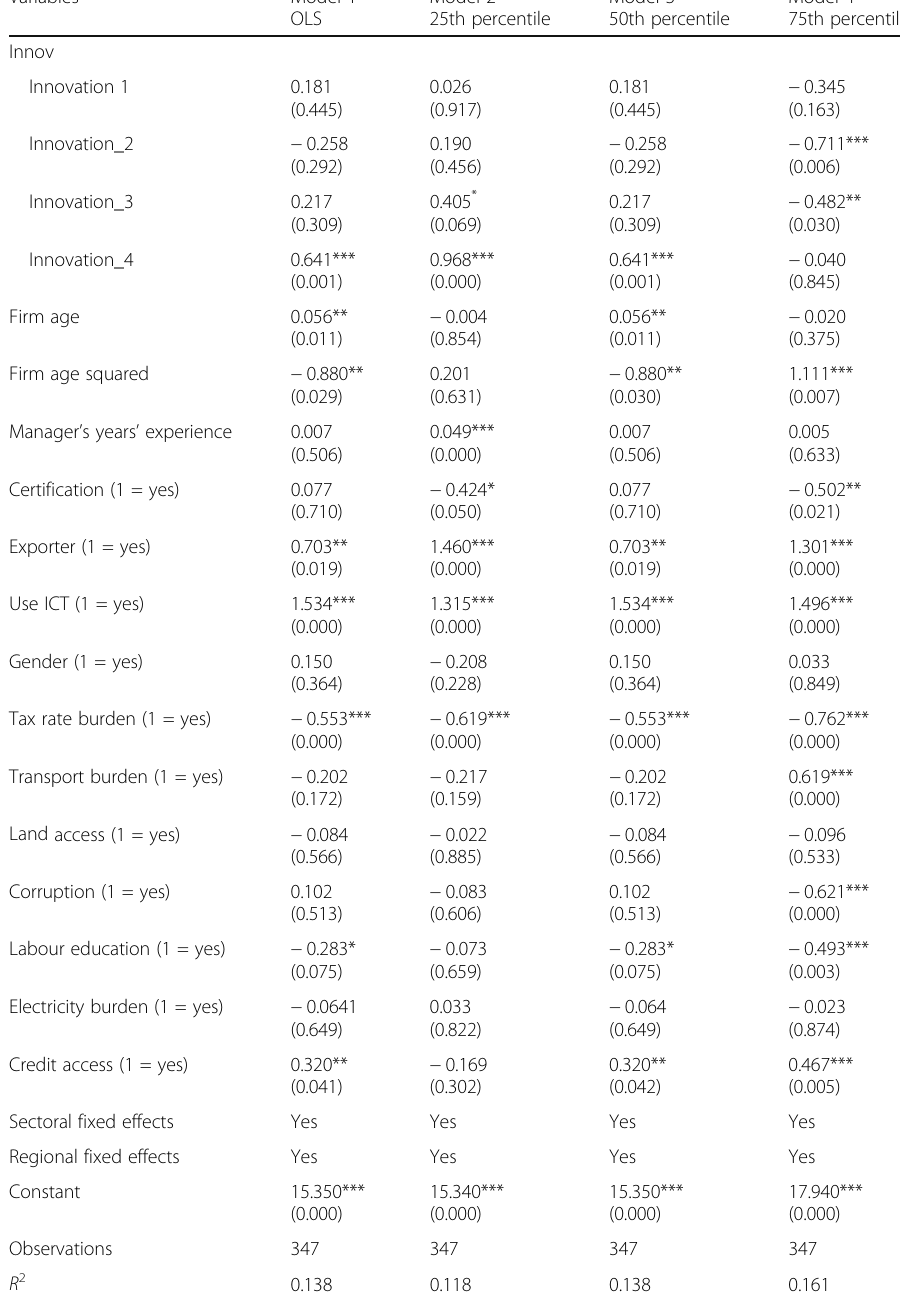
Table 2 Innovation and labour productivity